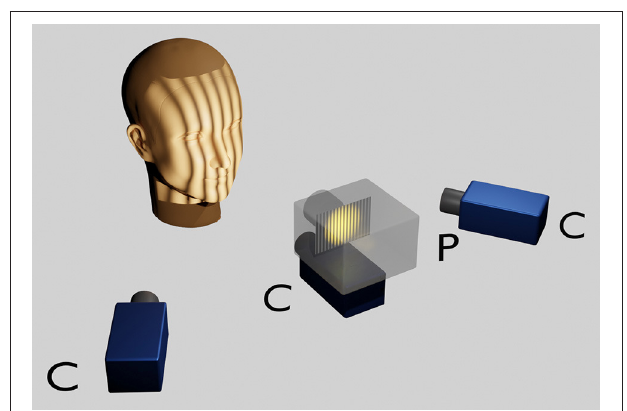
FIGURE 1 | Optical 3D measurement system based on the fringe projection technique. The head of the sitting patient, positioned at a defined distance from the scanner is adjusted according to the Frankfort horizontal and the pupillary planes parallelised to the ground horizontal with the aid of a light projection. A LCD projector in the middle projects a sequence of binary and sinusoidal vertical stripes onto the face, which are recorded by three charge coupled device (CCD) cameras. Within approximately 1s a point cloud consisting of approximately 50,000–800,000 facial 3D coordinates is rendered per